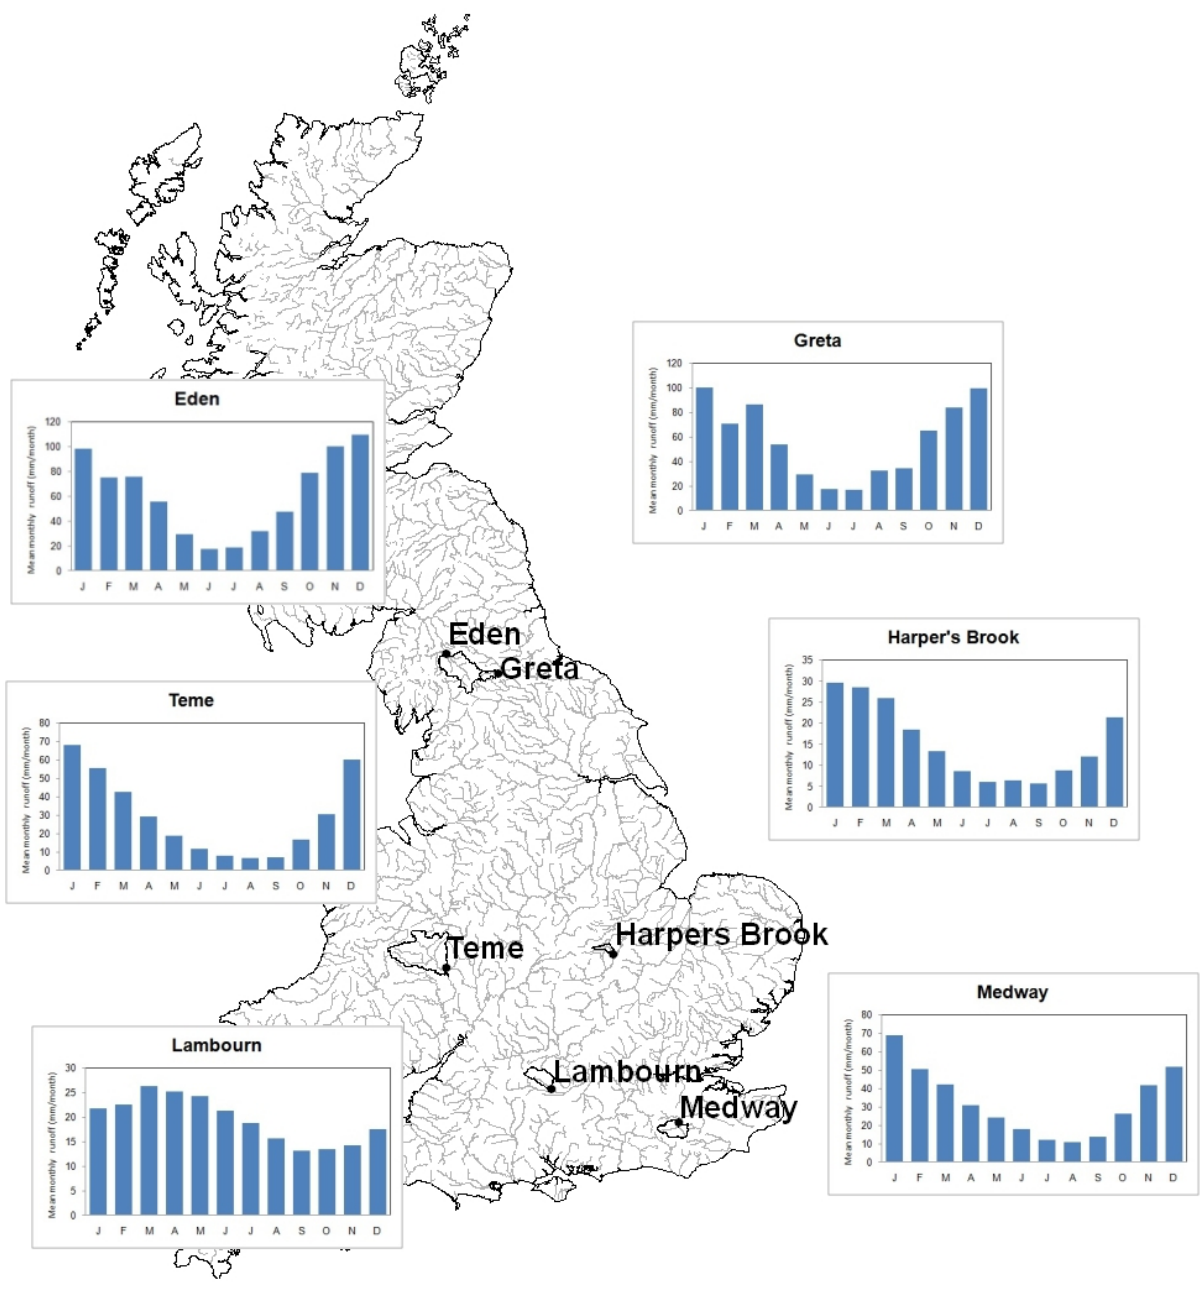
Fig. 1. Catchment locations and monthly hydrological regimes. Catchment map© NERC (CEH). Contains Ordnance Survey data© Crown copyright and database right 2011. River network from Moore et al. (1994), catchment boundaries from Morris and Flavin (1994), and river flow data from the National River Flow